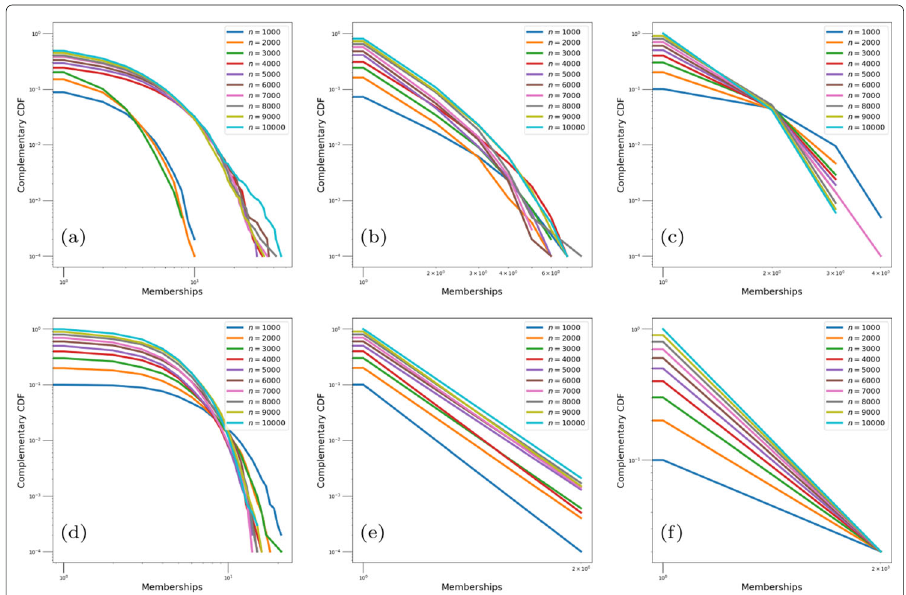
Fig. 13 Variation of the number of nodes ( n ) for LFR synthetic networks considering the membership of nodes: a Bigclam; b CFinder; c Copra; d Demon; e SLPA; f Ground-Truth